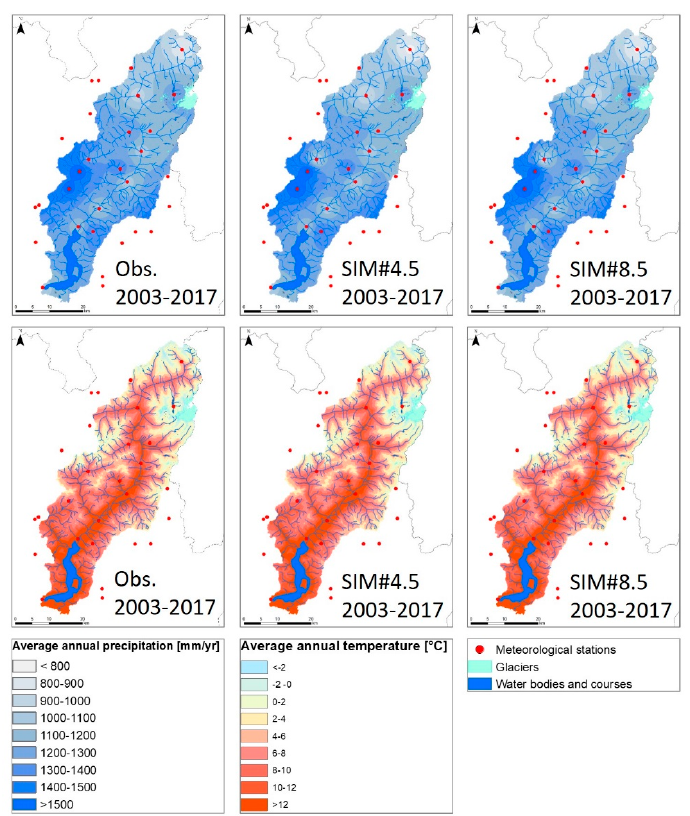
Figure 4. Estimates of mean annual precipitation (first row) and temperature (second row) based on observations in 2003–2017 (first column); statistical downscaling of SIM#4.5 in 2003–2017 (second column) and statistical downscaling of SIM#8.5 in 2003–2017 (third column). Table 3. Mean annual precipitation [mm yr -1 ] based on spatially distributed observations and simulated climate.